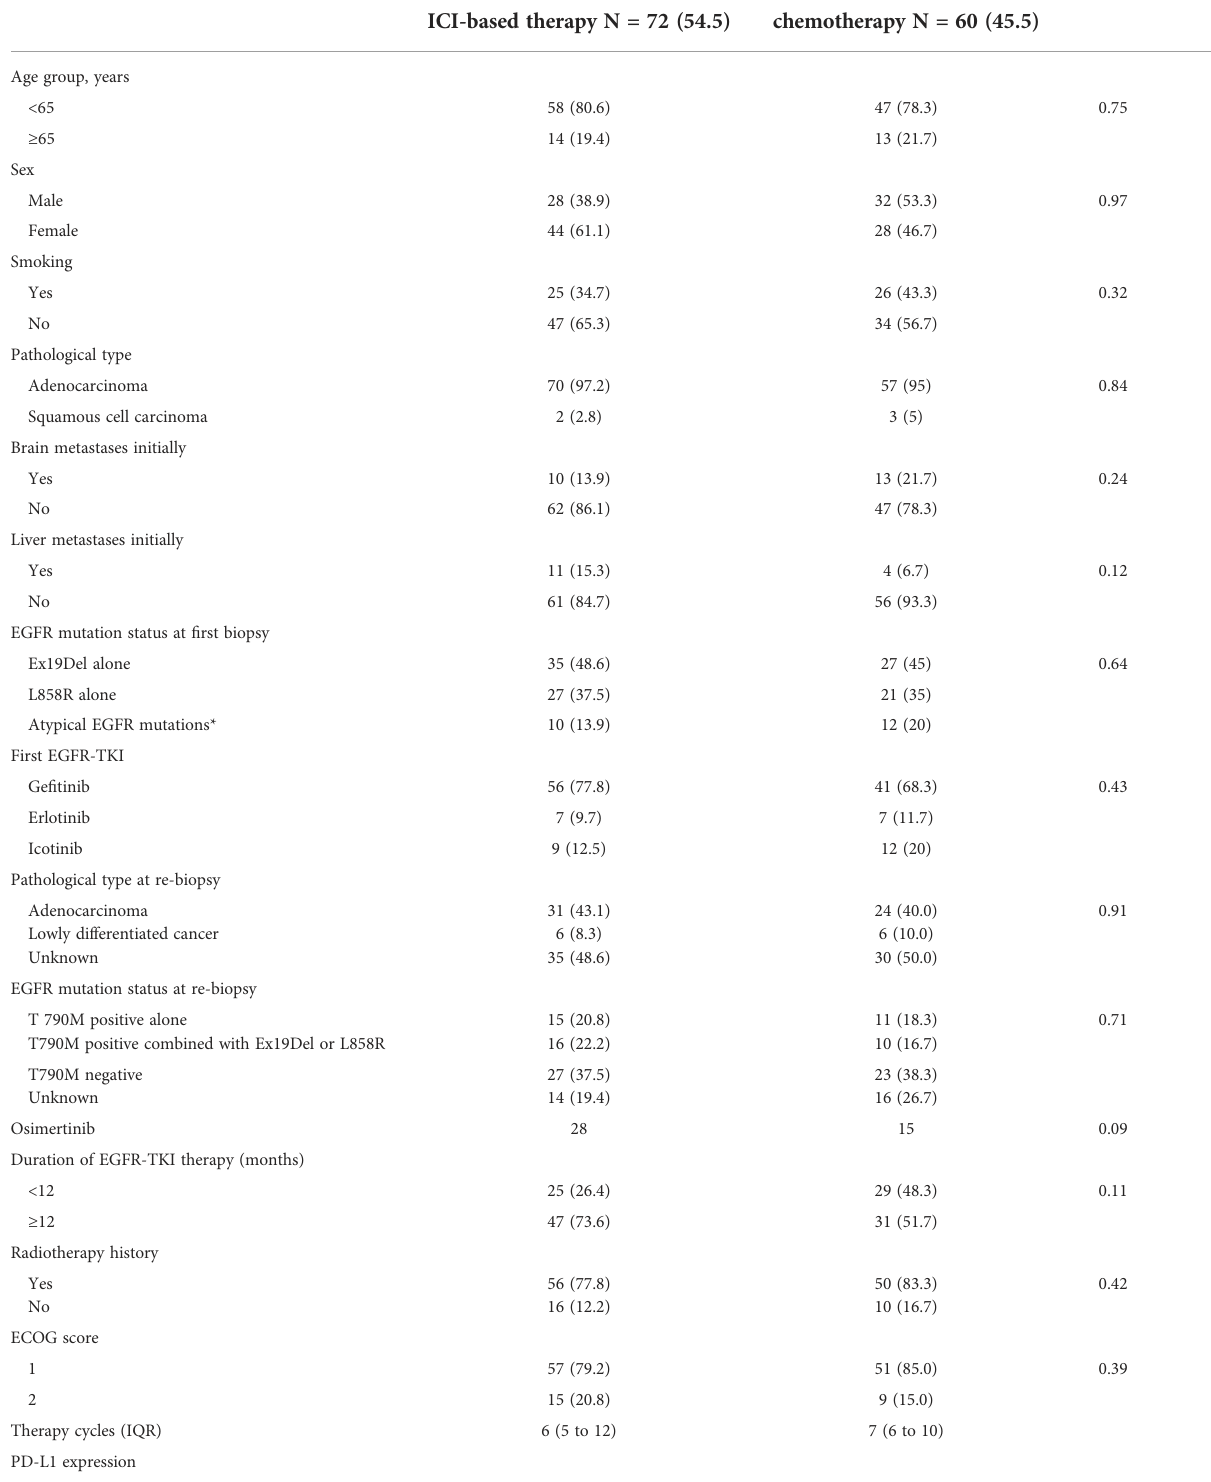
TABLE 1 Baseline characteristics of the study